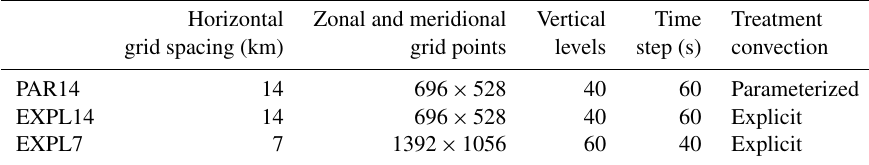
Table 1. Overview of the three model simulations and their configurations. Horizontal Zonal and meridional Vertical Time Treatment grid spacing (km) grid points levels step (s) convection PAR14 14 696 × 528 40 60 Parameterized EXPL14 14 696 × 528 40 60 Explicit EXPL7 7 1392 × 1056 60 40